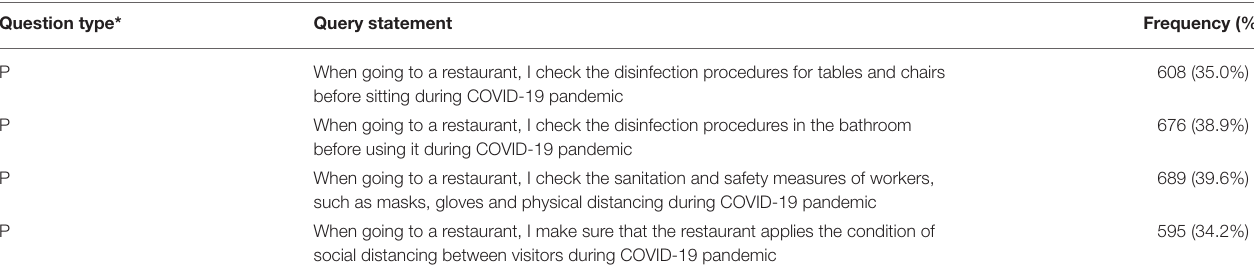
TABLE 6 | Query statements and responses of “restaurant hygiene”